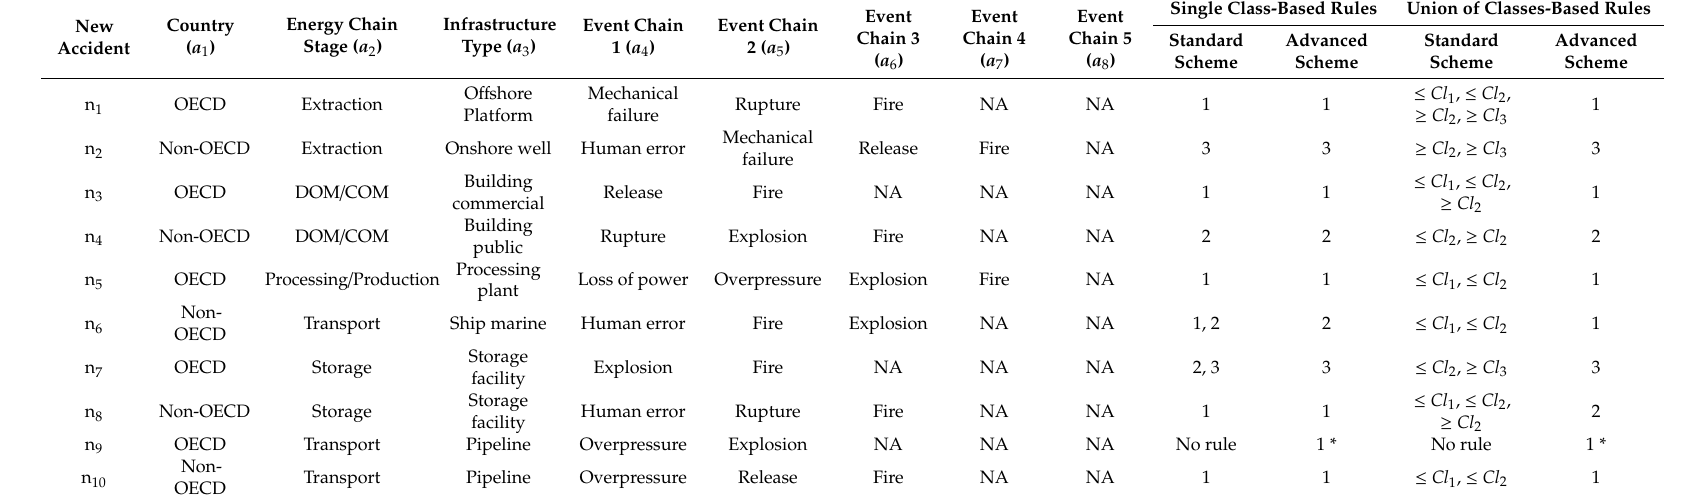
Table 4. Set of energy accidents sorted in hazard classes with the single class-based and union of classes-based classification